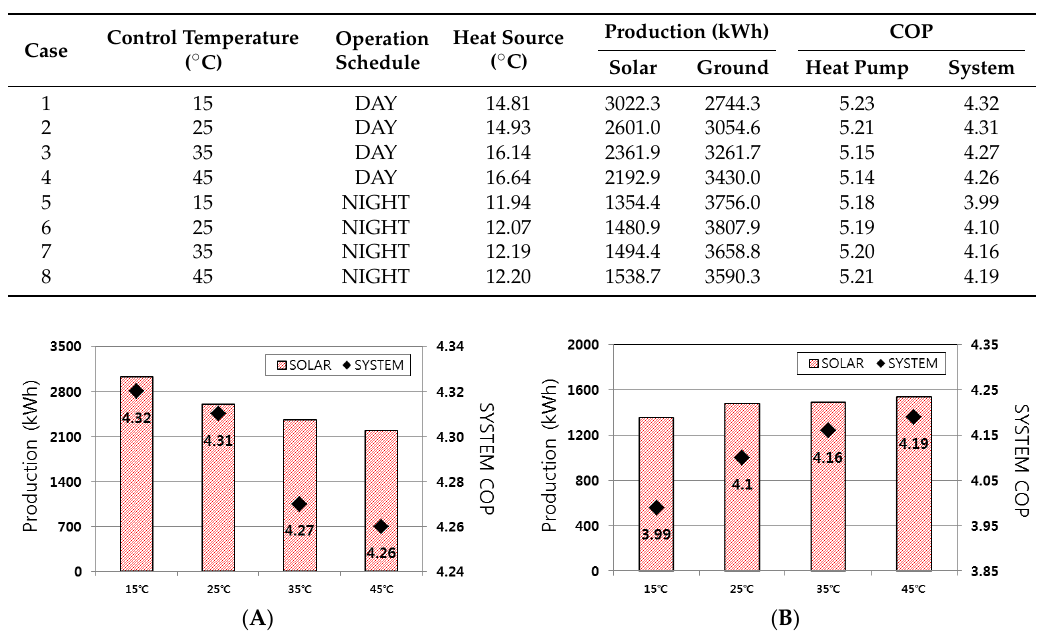
Table 3. Simulation results according to the control temperature in SYSTEM 2.